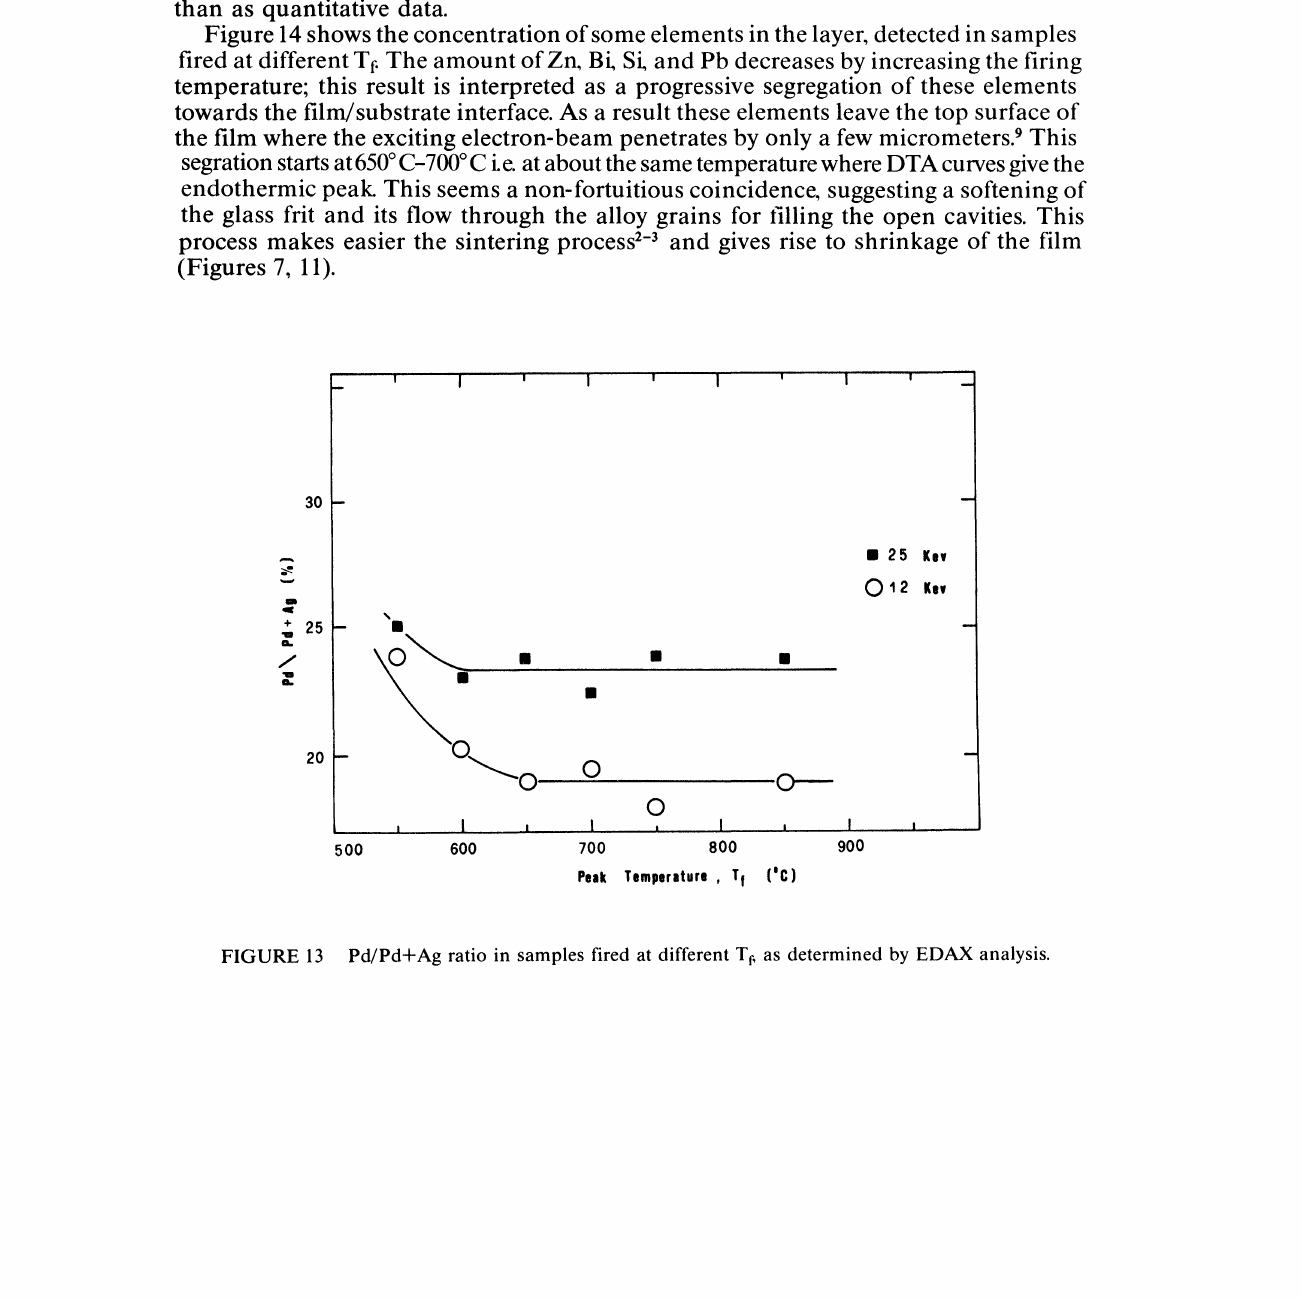
FIGURE 13 Pd/Pd+Ag ratio in samples fired at different Tf, as determined by EDAX